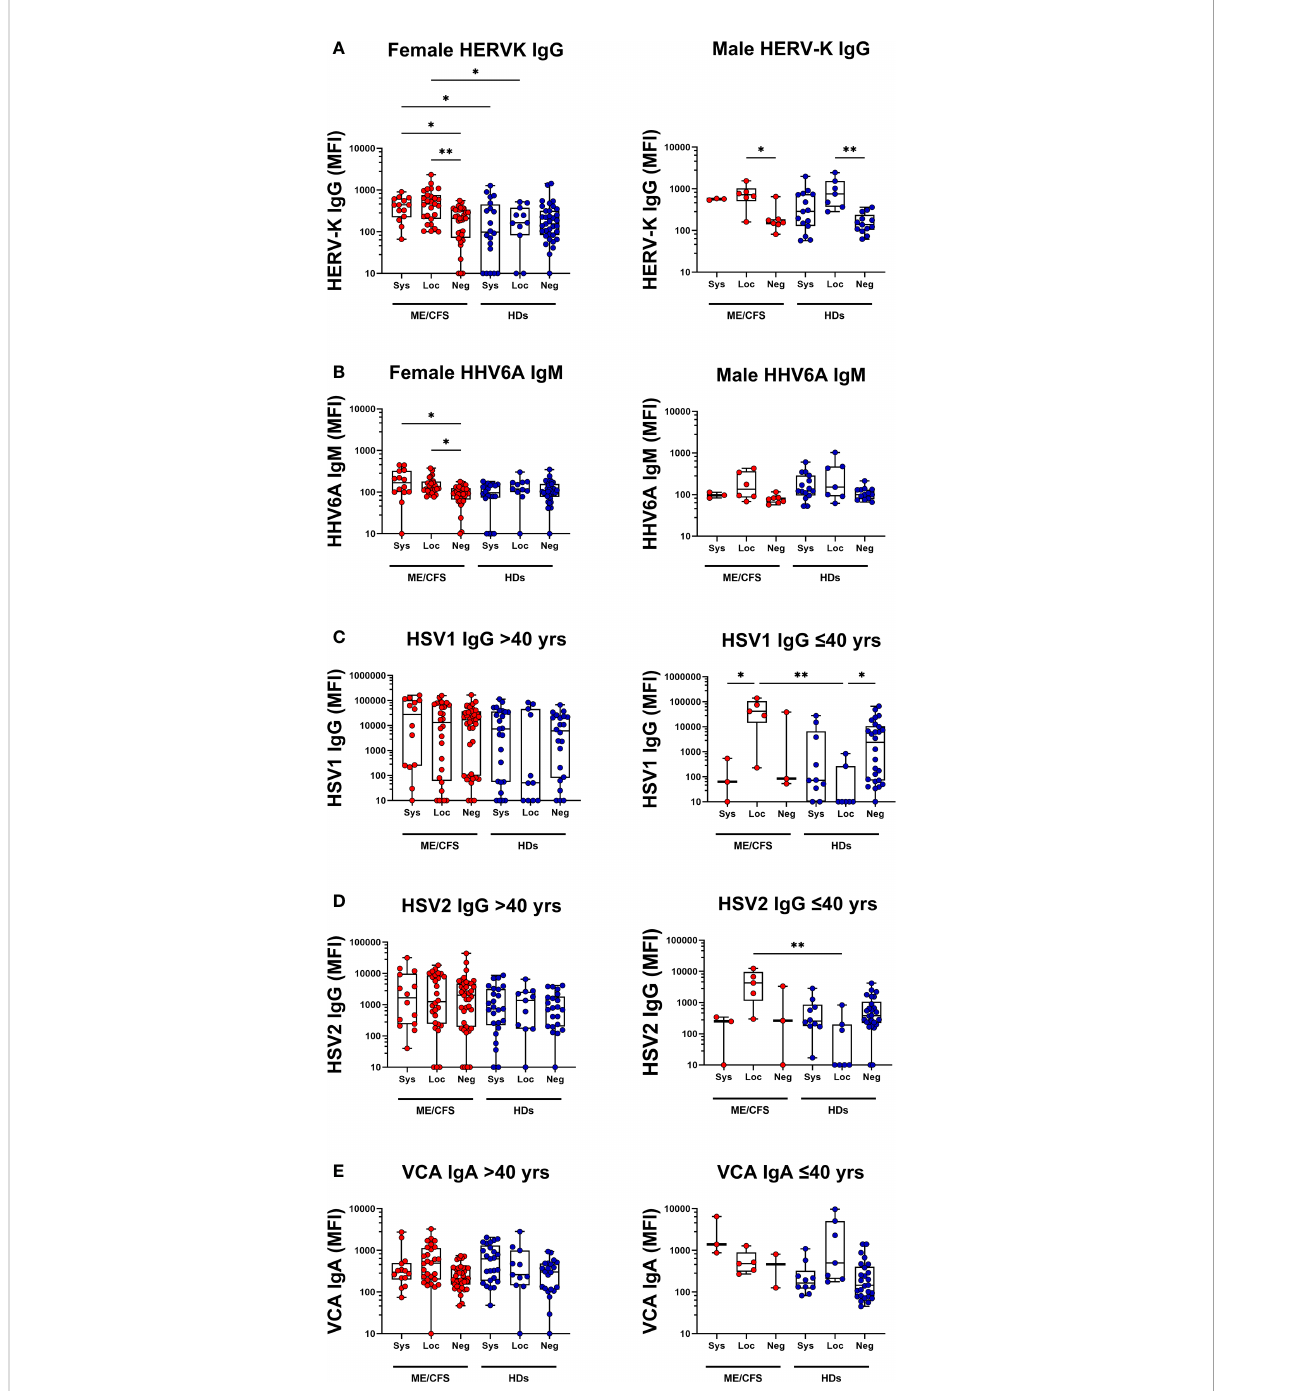
FIGURE 5 Female vs Male saliva and age-based antibody pro fi le comparisons in patients with ME/CFS (ME) and healthy donors (HDs). Male/Female IgG responses against (A) human endogenous retrovirus K (HERVK) and (B) IgM responses against human herpesvirus 6A (HHV6A) in all female and male participants. (C) Age-dependent IgG responses against herpes simplex virus 1 (HSV1) for participants under 40 years of age (left graph) and over 40 years of age (right graph). IgG responses against herpes simplex virus 2 (HSV2) (D) for participants under 40 years of age (left graph) and over 40 years of age (right graph). (E) IgA responses against VCA for participants under 40 years of age (left graph) and over 40 years of age (right graph). Sys, participants RBD-positive for systemic response in plasma. Loc, participants RBD-positive for local response in saliva. Neg, participants RBD-negative both in plasma and saliva. Data are presented as boxplots with median values with 25 th and 75 th percentile. MFI, median fl uorescence index. Statistically signi fi cant differences according to non-parametric Kruskal-Wallis procedure and false discovery rate adjustment (5%), are indicated as * p < 0.05 , ** p < 0.01